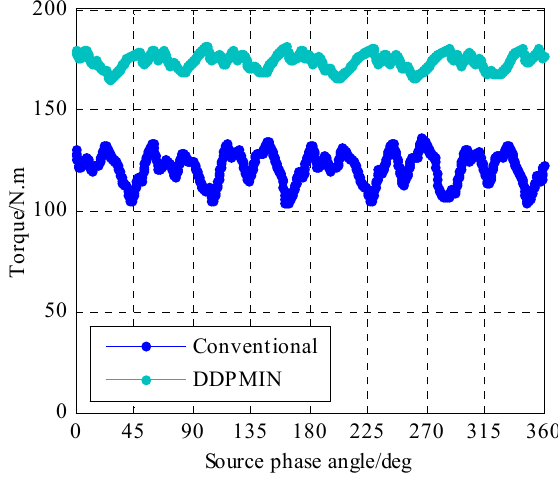
Figure 15. Torque curves.